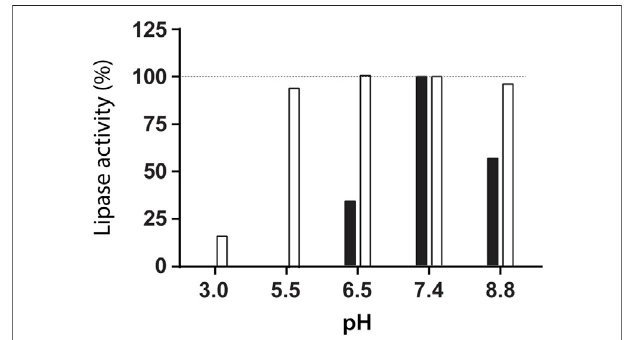
FIGURE 2 | Lipase activity measured at pH = 7.4 and 37 ° C after incubation for 6 h at room temperature at the indicated pH (white, □ ) and lipase activity assayed at the indicated pH and 37 ° C (black, ■